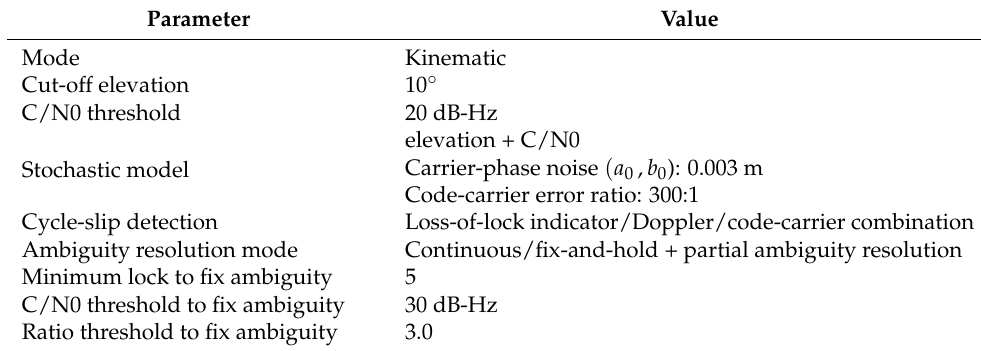
Table 2. Parameter settings for real-time kinematic (RTK)